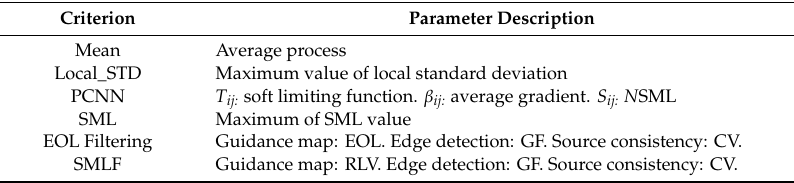
Table 2. Parameter description of low frequency fusion criteria. NSML, novel sum-modified Laplacian; SMLF, SML energy filtering; PCNN, pulse coupled neural network; EOL, energy of Laplacian; RLV, relating sum-modified Laplacian energy with visual contrast value; GF, guided filter; CV, consistency verification.